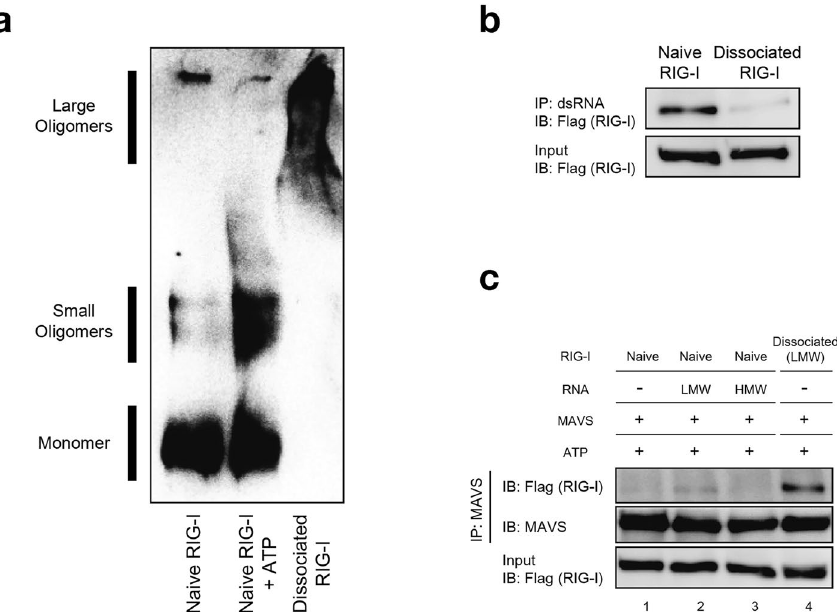
Figure 4. Biochemical characterization of dissociated RIG-I. ( a ) Native PAGE analysis of naïve RIG-I and dissociated RIG-I (293 T cells). Naïve RIG-I in the absence or presence of 1 mM ATP and dissociated RIG-I were applied to native PAGE and analyzed by immunoblotting by anti-Flag. The positions of monomers, small oligomers and large oligomers are indicated. The uncropped original blot is shown in Supplementary Fig. S9a. ( b ) Binding activity of naïve or dissociated RIG-I to LMW poly (I:C) was examined. Recombinant naïve and dissociated RIG-I (20 ng each) were subjected to binding assay with LMW poly (I:C). After incubation at 37 °C for 30 min, RIG-I associated with magnetic beads was analyzed by immunoblotting (IP: dsRNA; IB: Flag (RIG- I)). Input: total amount of naïve and dissociated RIG-I subjected to the binding assay. The uncropped original blots are shown in Supplementary Fig. S9b. ( c ) Physical interaction of RIG-I with MAVS. Naïve RIG-I (lanes 1, 2, and 3) or RIG-I dissociated from LMW poly (I:C) (lane 4) was mixed with recombinant MAVS ( Δ TM, METHODS). LMW and HMW poly (I:C) were included in lanes 2 and 3, respectively. After incubation at 37 °C for 30 min, the mixtures were subjected to immunoprecipitation with anti-MAVS, followed by immunoblotting with anti-Flag (RIG-I) and anti-MAVS. Input: total amount of RIG-I subjected to the assay. The uncropped original blots are shown in Supplementary Fig.